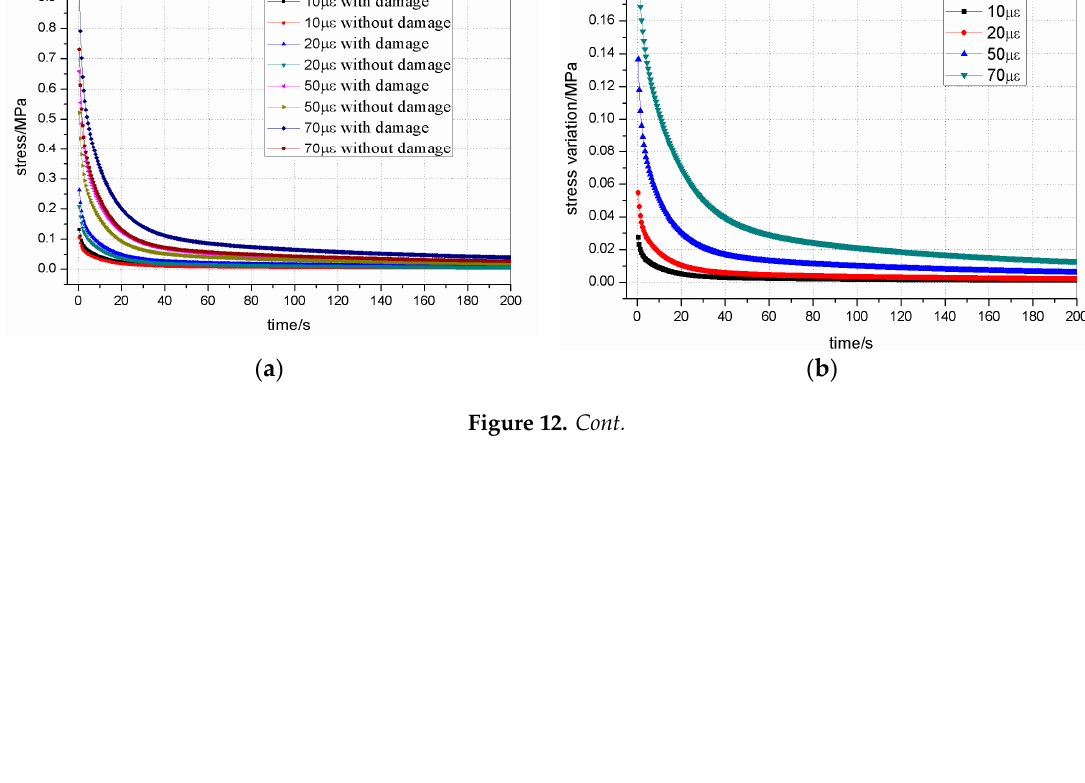
Figure 11. Selected locations for analysis from the digital sample.